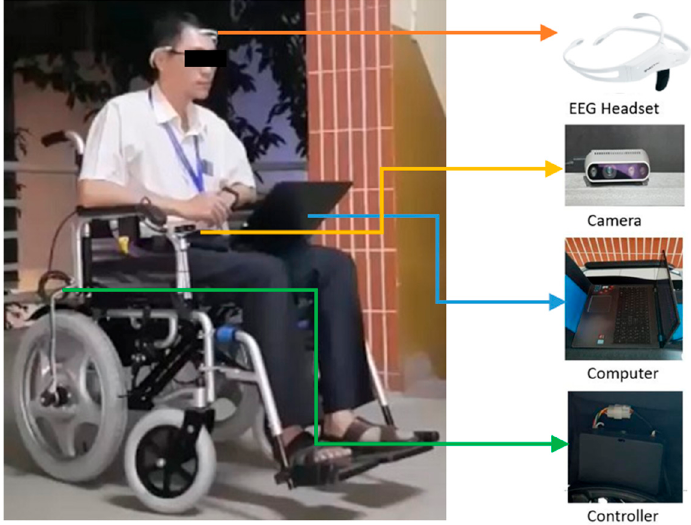
Figure 12. The wheelchair navigation system installed with devices.